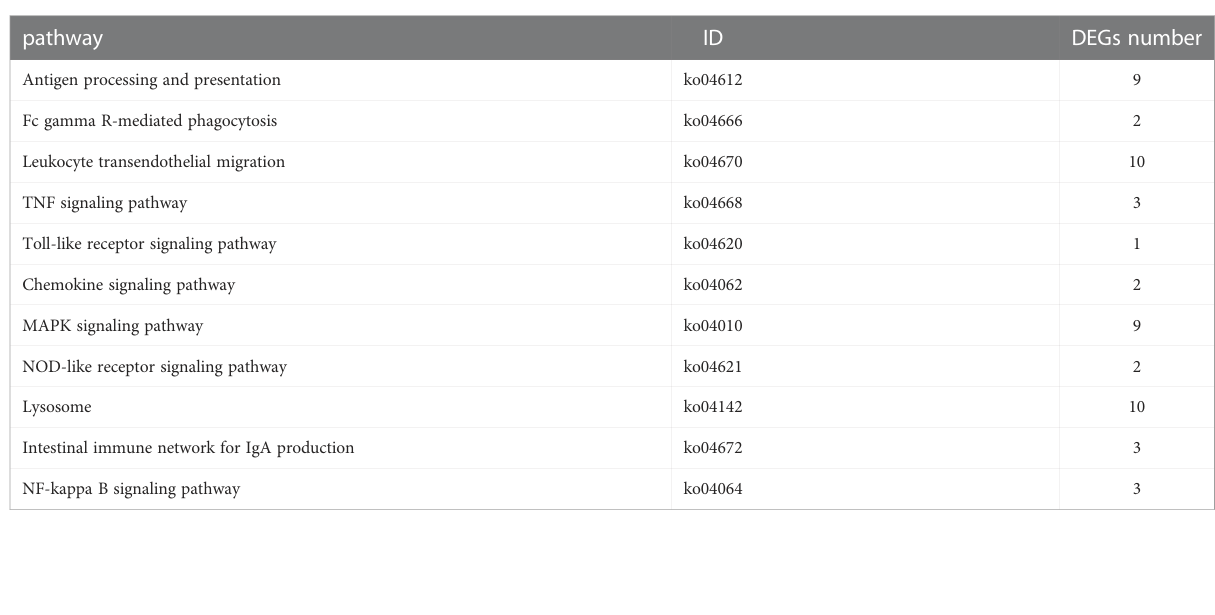
TABLE 6 KEGG annotation of assembled